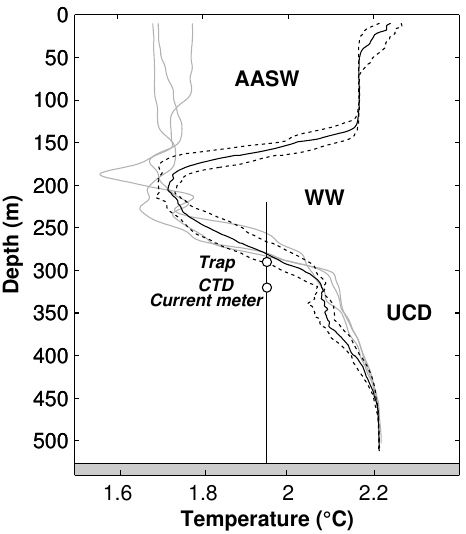
Figure 2. Schematic of the instrumented mooring line against ver- tical temperature profiles. The sediment trap and the current me- ter/CTD sensor location on the mooring line are shown by white circles. Temperature profiles performed during the sediment trap deployment (20 October 2011) are represented by grey curves. The solid black curve is the median temperature profile from 12 casts re- alized on the 16 November 2011. Dashed black lines are the first and third quartiles from these casts. The grey rectangle represents the Kerguelen Plateau seafloor. The different water masses are Antarc- tic Surface Water (AASW), Winter Water (WW) and Upper Cir- cumpolar Deep Water